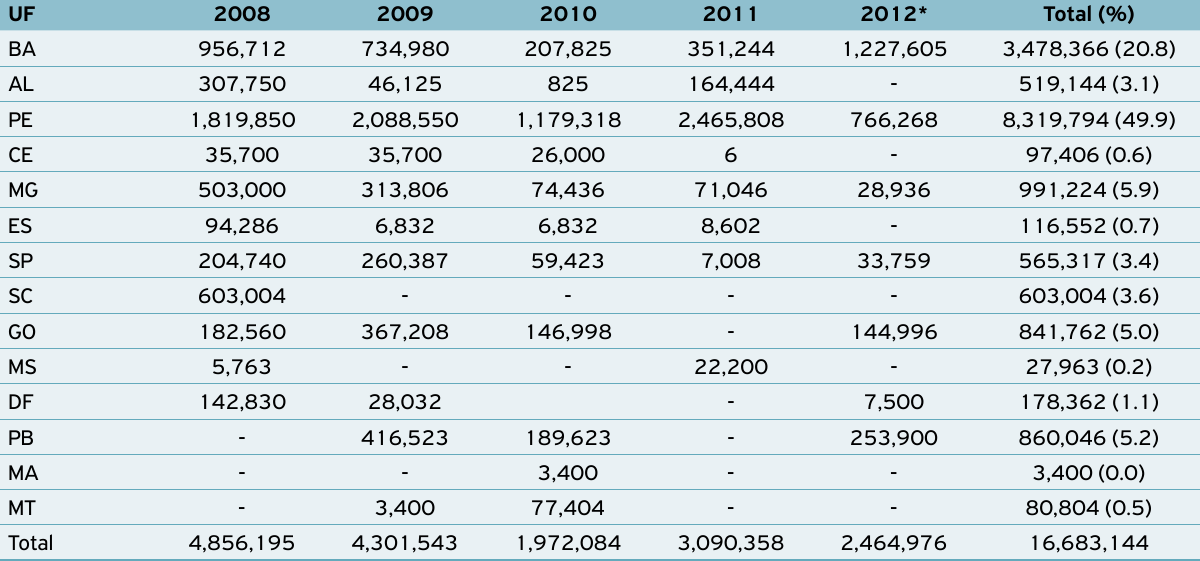
Table 2. Destination of poultry from the state of Sergipe, Brazil, 2008–2012.